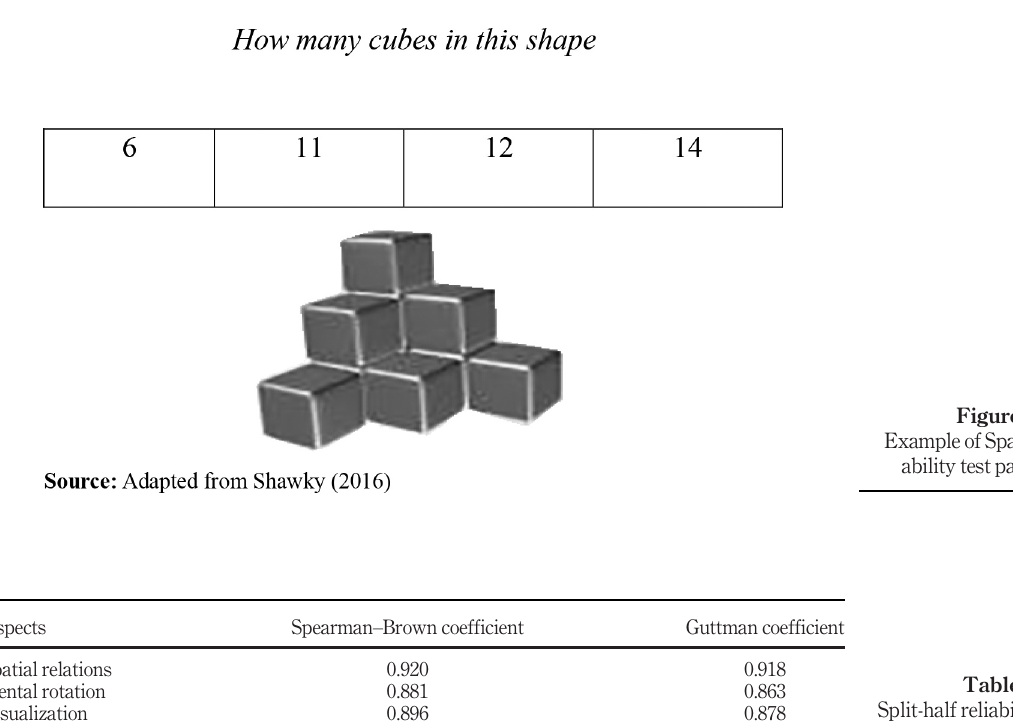
Table 1. Split-half